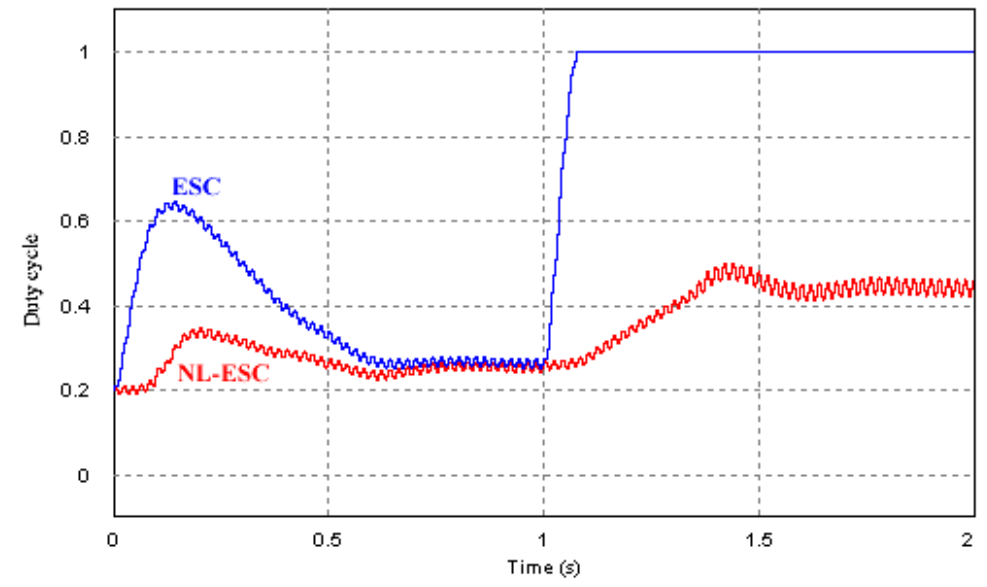
Figure 17. Transient of duty-cycle in front an abrupt irradiance increase in NL-ESC case ( Red ) and in ESC case ( Blue ).